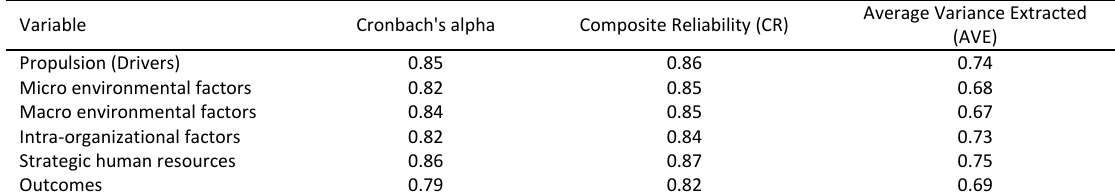
Table 2: Cronbach's alpha values, composite reliability and AVE Table 2: Cronbach’s alpha values, composite reliability and AVE